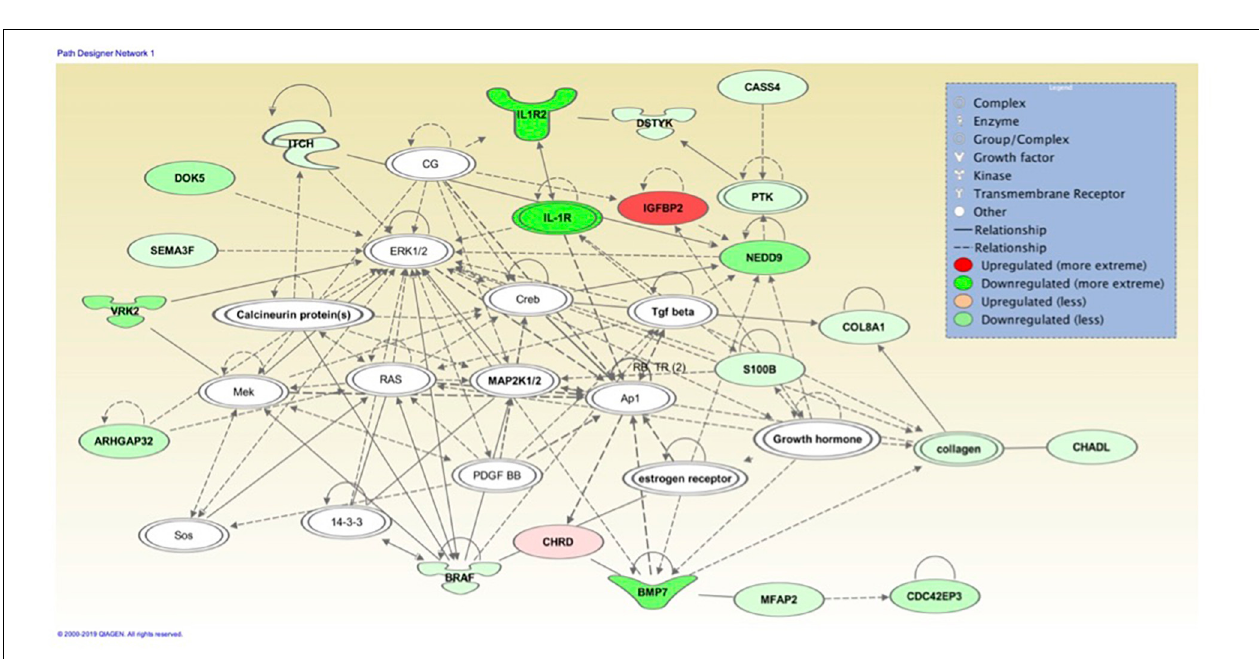
FIGURE 7 | Associated network function in IPA for the liver transcriptome dataset of birds with normal PM compared to severe/moderate WB: Connective Tissue Disorders, Hematological Disease, Hereditary Disorder .